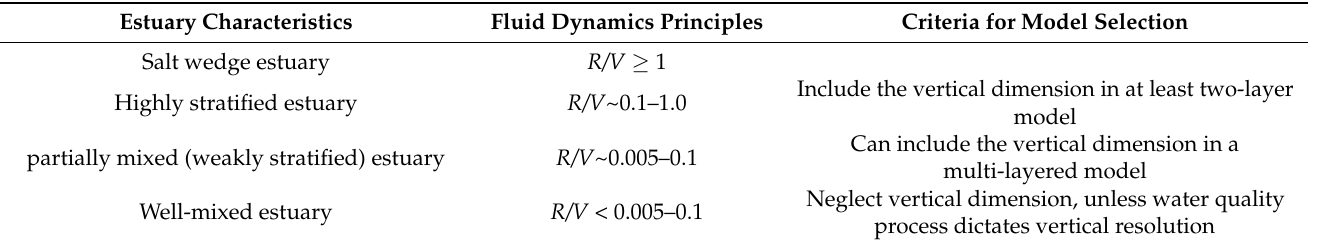
Table 1. Classification of estuaries by Water Circulation